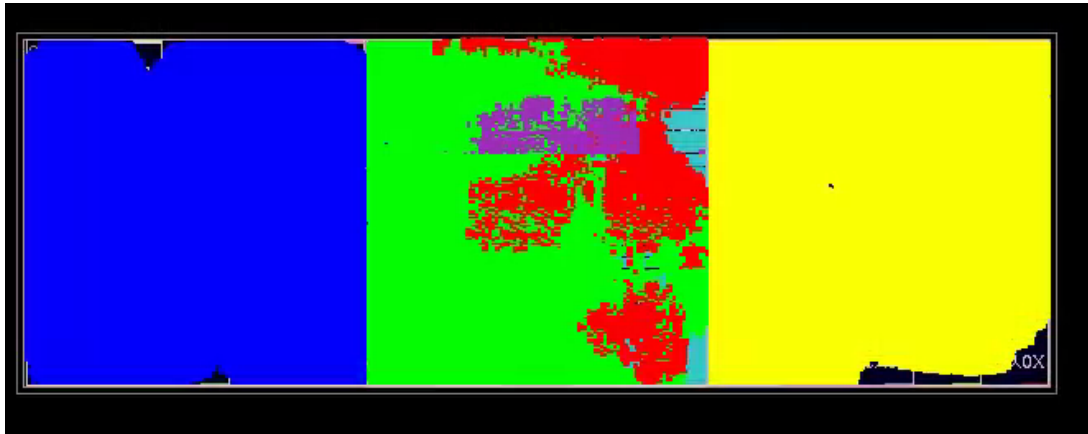
Figure 8. Routed FPGA design with three 512-bit Hamming DCUs, 128 PE each. Yellow: DCU_0, green: DCU_1, blue: DCU_2, purple: DDR, red: